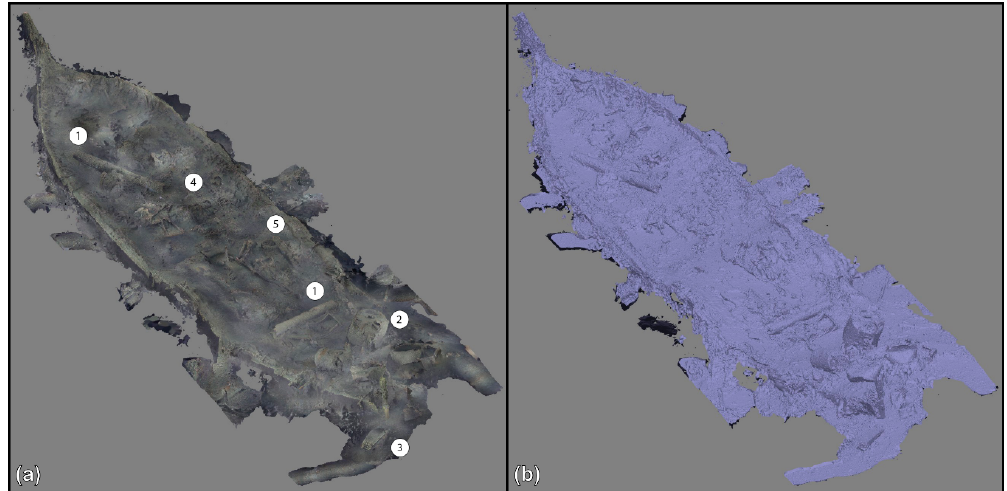
Figure 7. Panel ( a ) shows the photogrammetric 3D model of the Figaro with: (1) Chimneys; (2) Boilers and vats; (3) Rudder; (4) Barrels; (5) Machine construction. Panel ( b ) shows the un-textured 3D model of the Figaro.